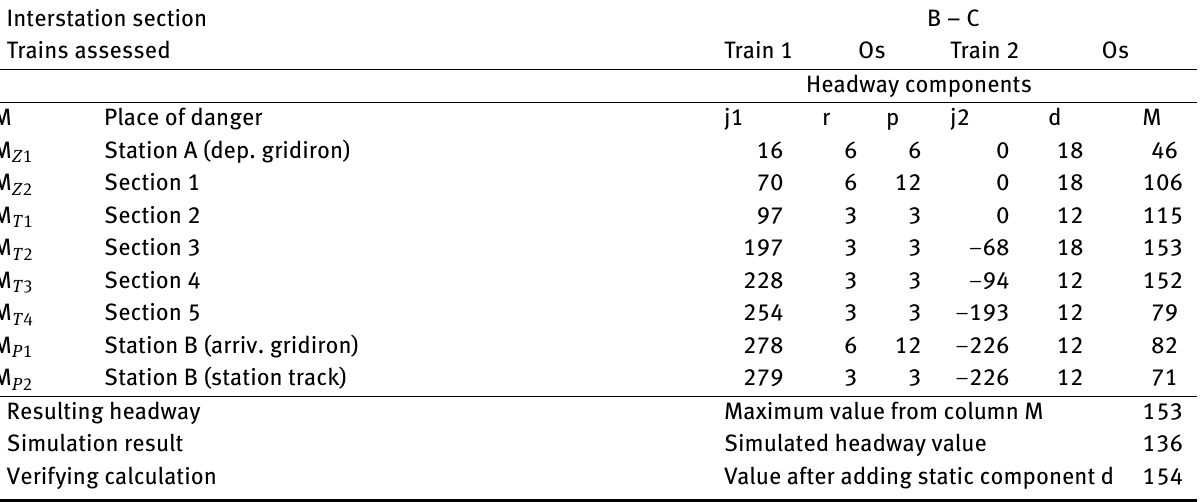
Table 4: Calculation of headways according to SM 104